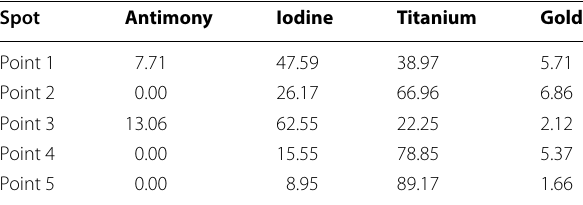
Table 3 Elemental distribution (atomic %) of the individual elements observed on particular spot